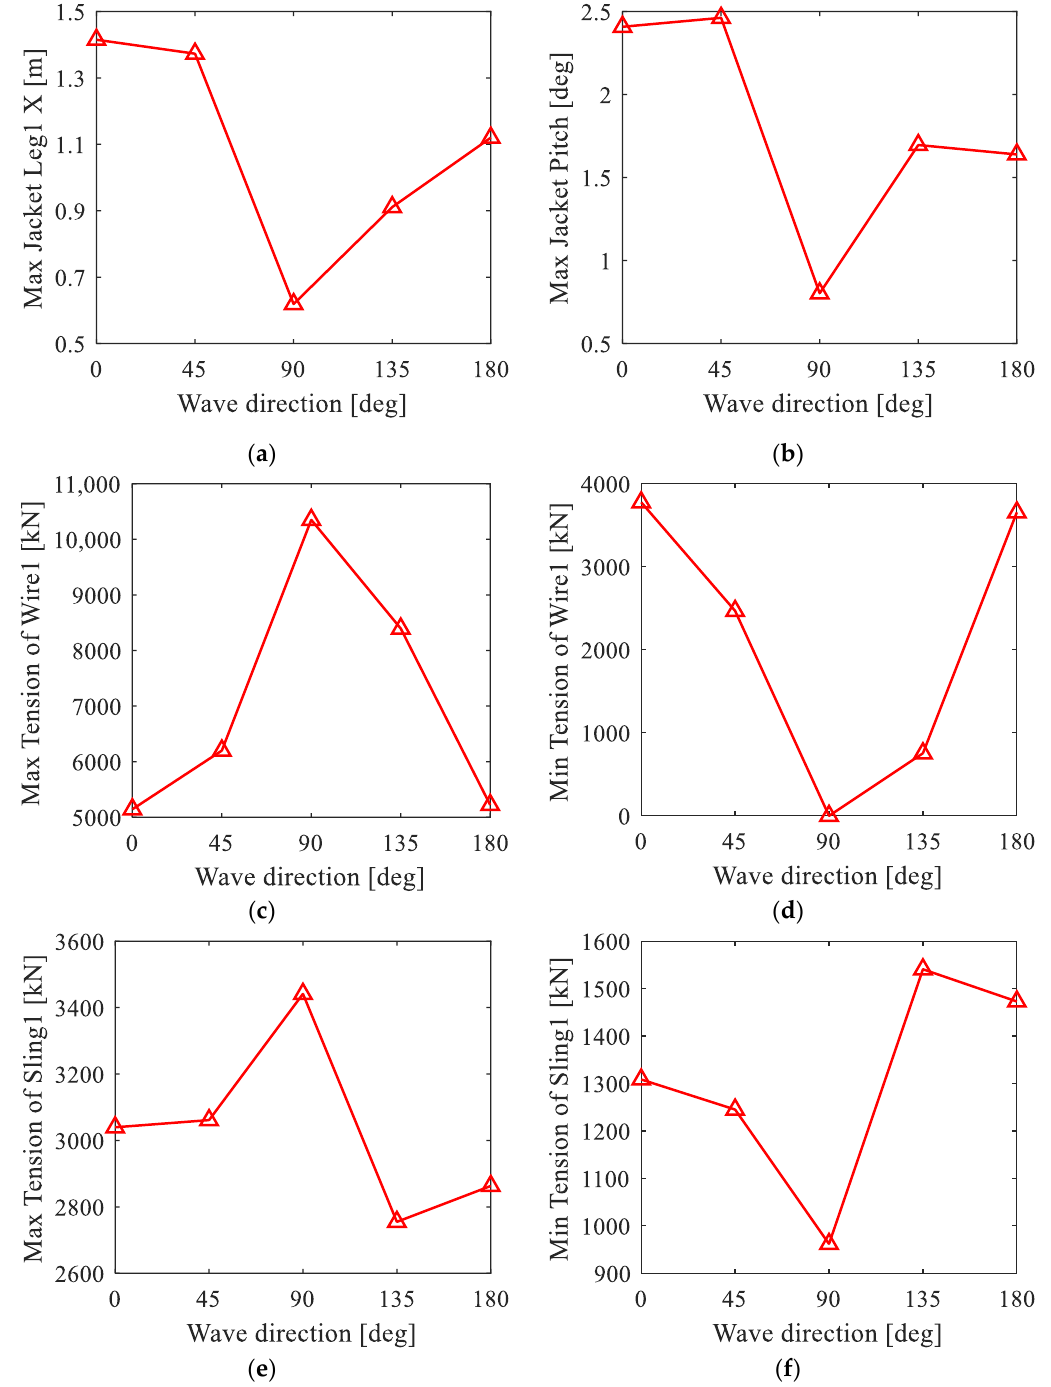
Figure 16. Extreme responses of several wave directions. ( H s = 1.5 m, T p = 7 s, JL1-Z3). ( a ) Max motion of jacket leg1 X; ( b ) Max motion of jacket pitch; ( c ) Max tension of wire1; ( d ) Min tension of wire1; ( e ) Max tension of sling1; ( f ) Min tension of